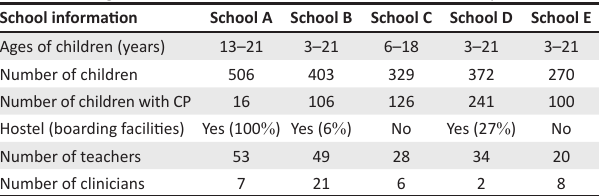
TABLE 2: Background information of schools included in the